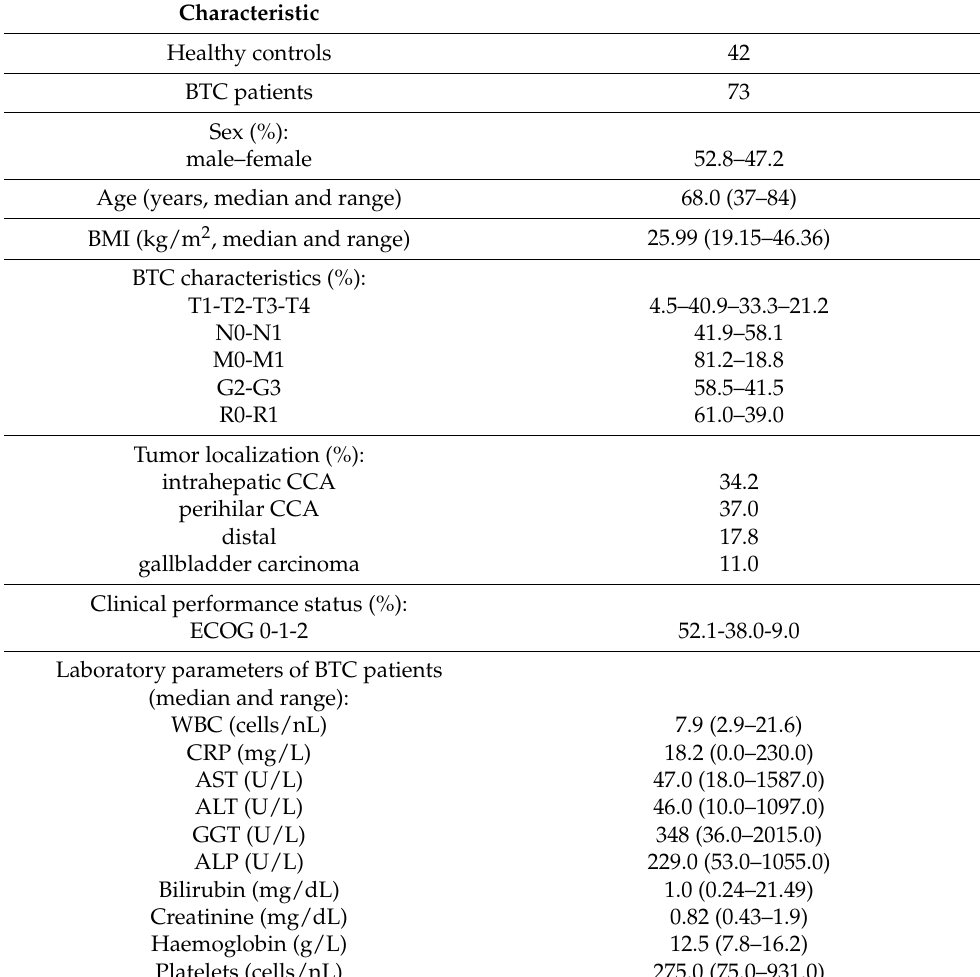
Table 2. Characteristics of the study population.